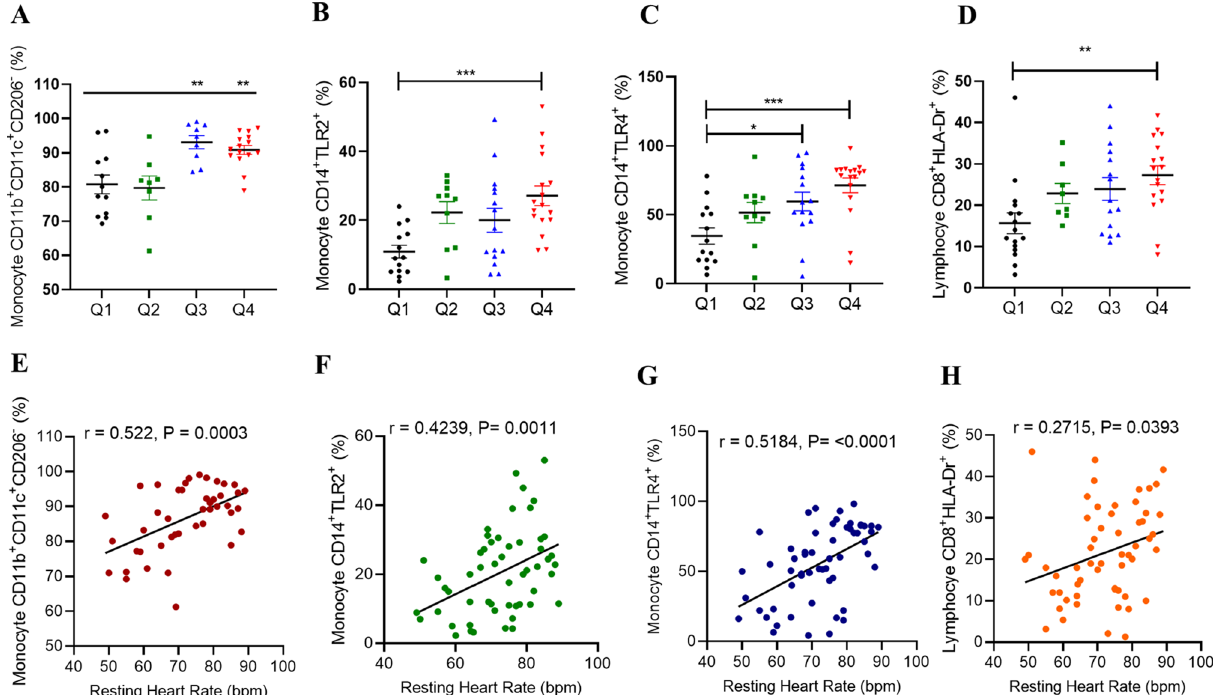
Figure 1. Association between RHR and leukocyte phenotypes in peripheral blood. Flow cytometry analysis was conducted to identify the expression levels of different inflammatory related leukocyte subsets expression cross RHR quartiles. Pro-inflammatory monocytes ( A ), TLR2 + monocytes ( B ), TLR4 + monocytes ( C ) and cytotoxic T cells ( D ). Pearson’s correlation coefficient analysis was conducted to investigate the relationship between RHR and measured leukocyte subsets expression ( E – H ). All data are expressed as mean ± SD. P ≤ 0.05 was considered statistically significant (*P < 0.01; **P < 0.001, ***P < 0.0001).